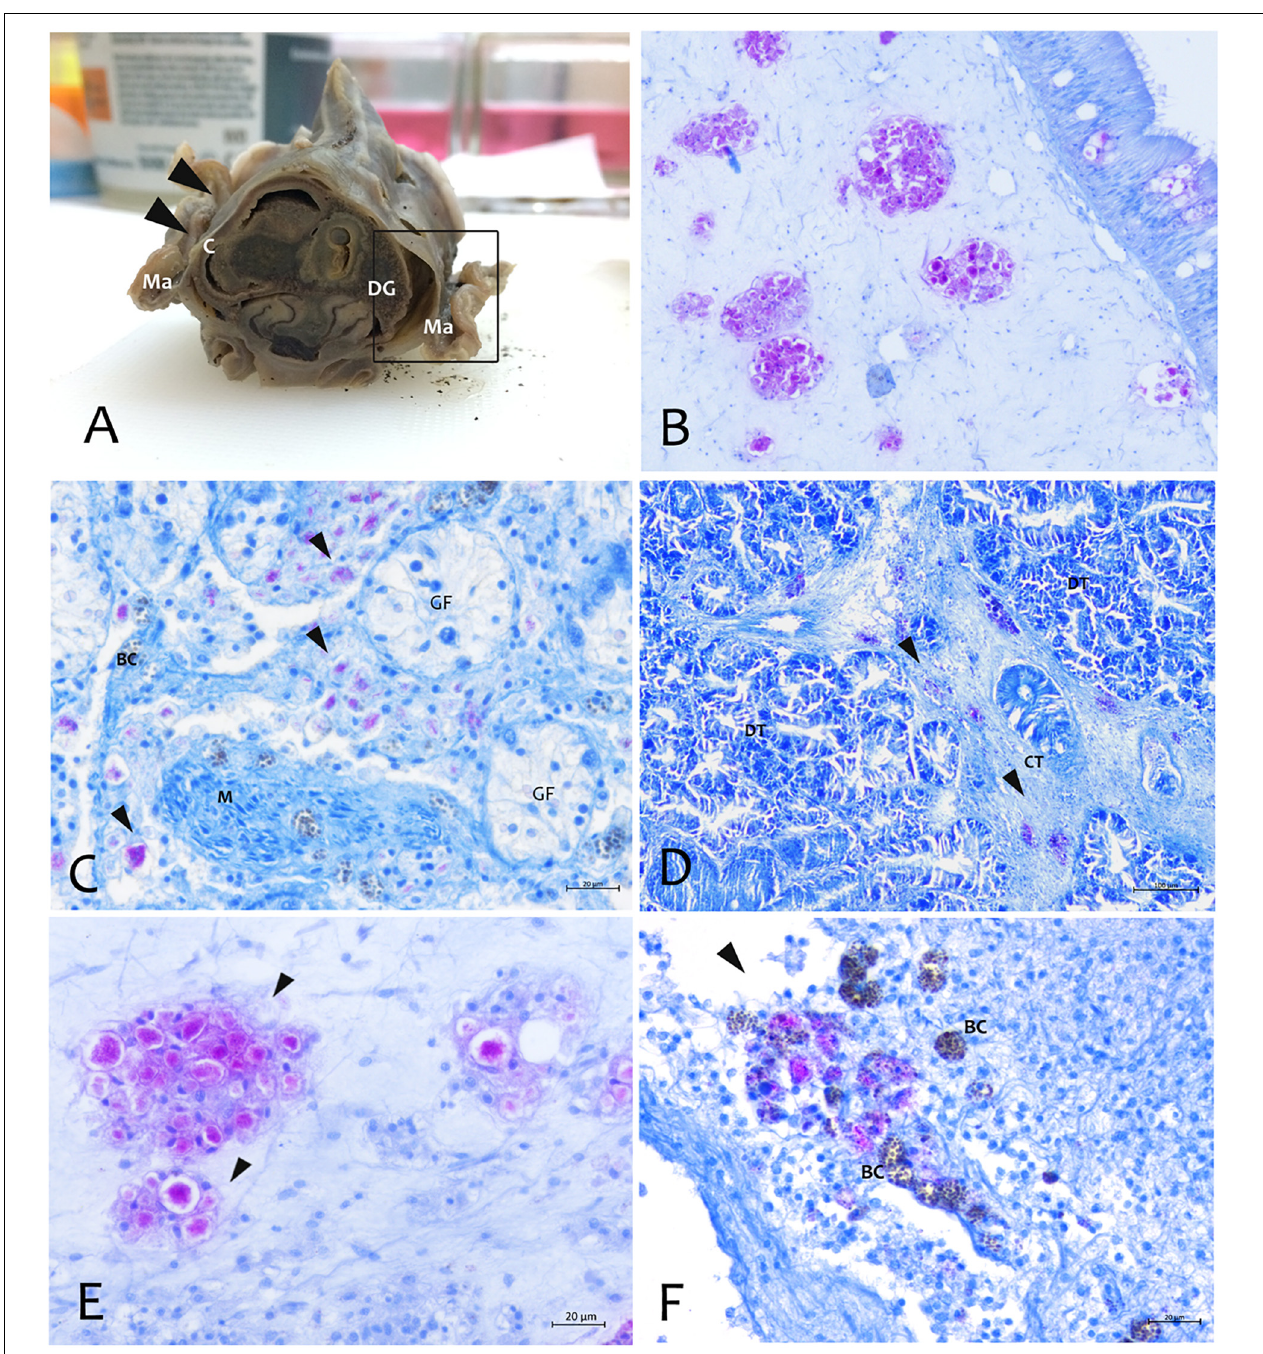
FIGURE 5 | Distribution of the Mycobacterium at tissue and organs level by Zhiel-Neelsen stain in P. nobilis specimens. (A) Gross observation of digestive system and mantle in transverse section showing tropism of M. at fibrous capsule circumscribing digestive gland (DG) and image at microscopic level (B) . (C) Tropism in the interstitial space of gonadal follicles (GF) and in the connective tissue of digestive gland (black arrows) (D) . (E) Mycobacteria present as aggregates filling immune cells (arrowheads) or present in few cells, and recalling a strong inflammatory response of haemocyte in the site of infection associated with Brown Cells (BC) (F) at mantle level; Ma, Mantle; Ct, Connective tissue; M, muscle; DT, Digestive tubules; C, connective